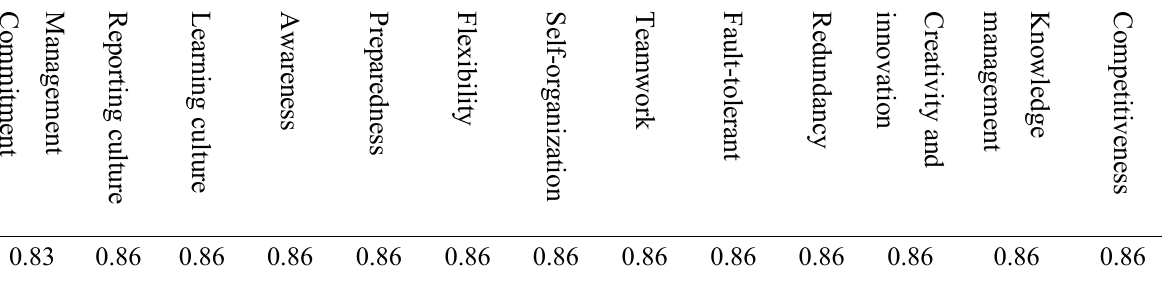
Table 3. Average efficiency for each eliminated factor based on sensitivity analysis